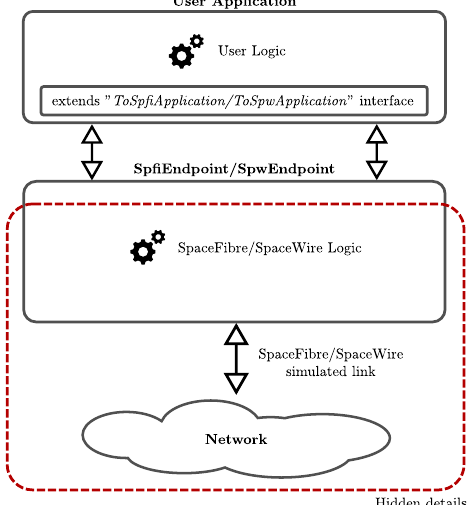
Figure 1. Interaction between User Application and SpaceFibre or SpaceWire